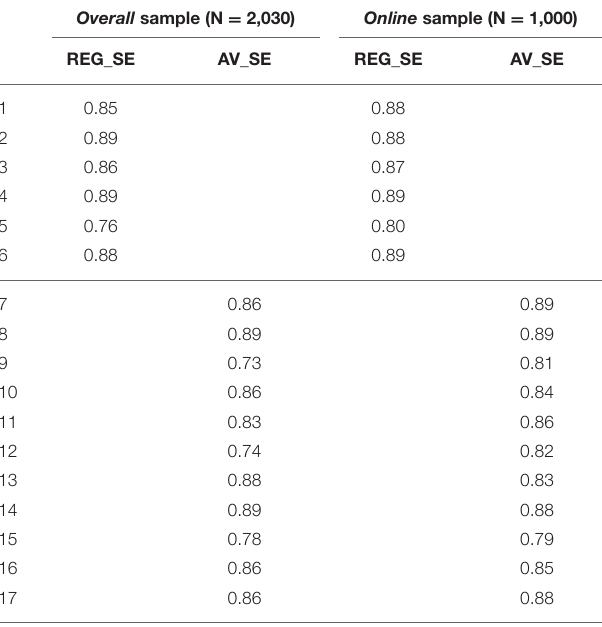
TABLE 3 | Standardized factor loadings on both samples for the CFA